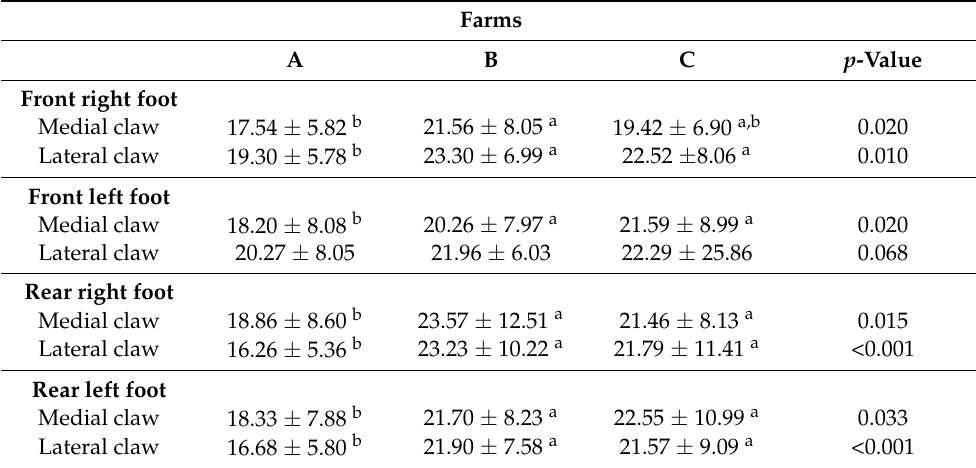
Table 3. Maximum stress values (mean ± SD) in MPa of medial and lateral claws of all feet of culled sows from three genetic